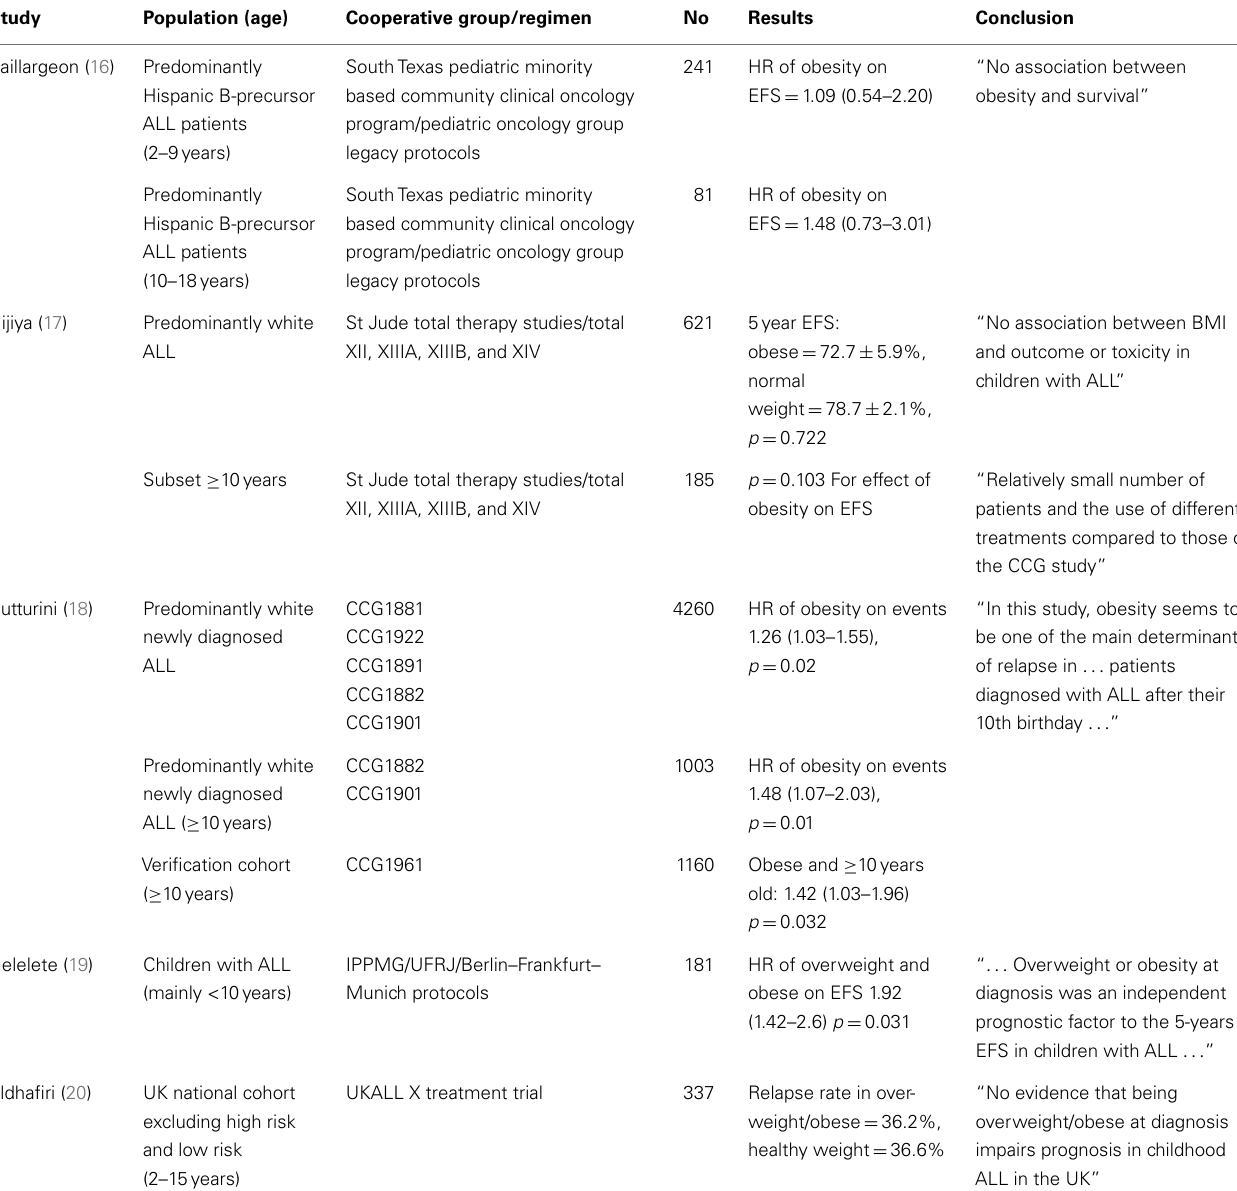
Table 1 | Retrospective studies examining the association between overweight/obesity andALL outcome (EFS, event free survival; HR, hazard ratio)